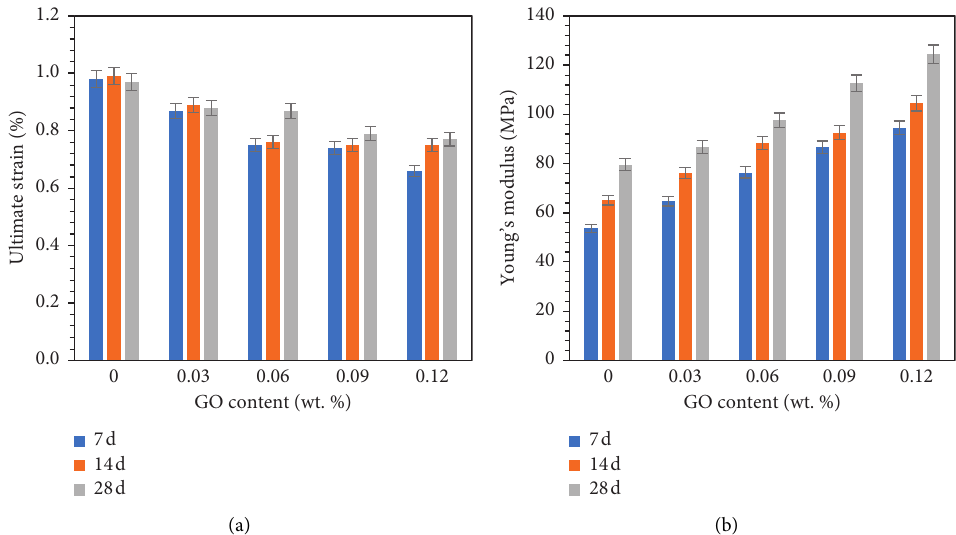
Figure 8: Ultimate strain and Young’s modulus of GO/cement/loess composites with different GO contents: (a) ultimate strain; (b) Young’s modulus.